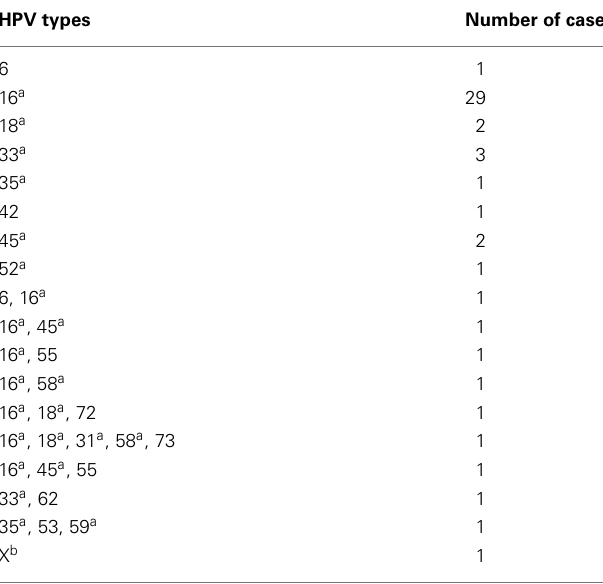
Table 2 | Characteristics of invasive penile cancer cases by HPV status ( n =